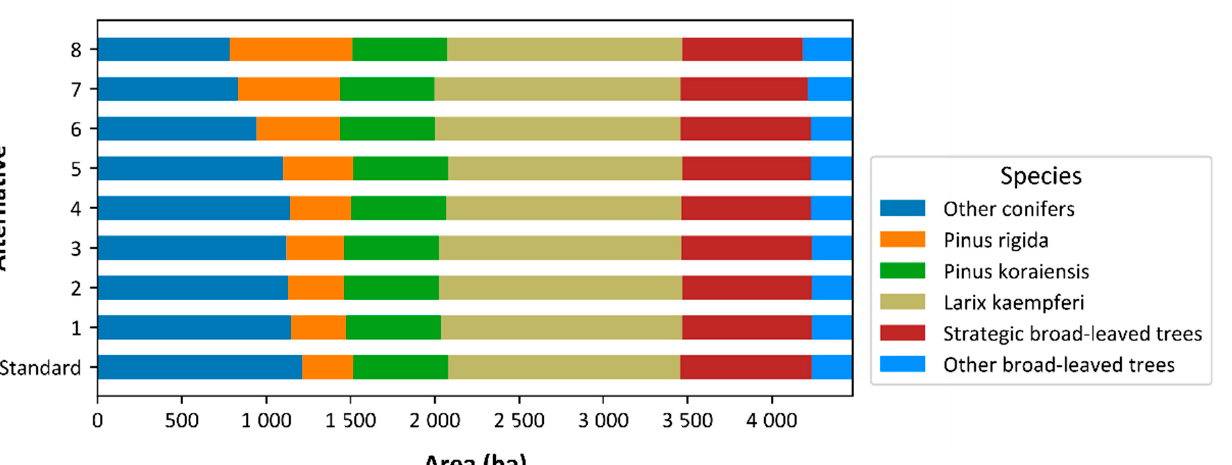
Figure 7. Total volume and NPV of carbon stored during the entire planning horizon for each man- agement alternative.